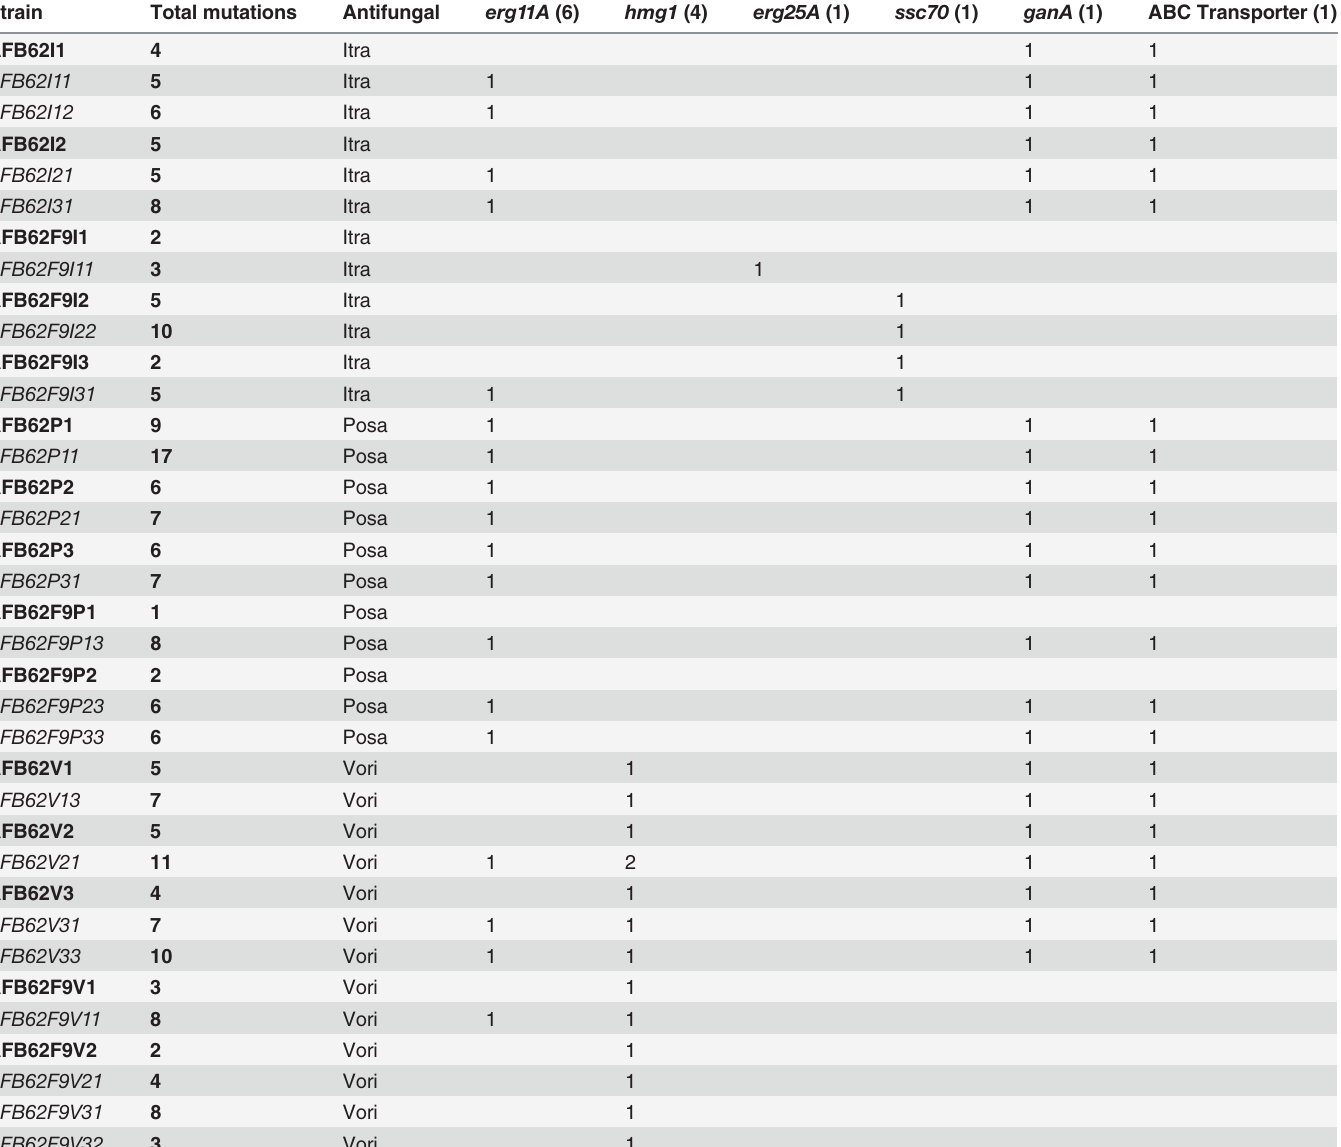
Table 1. Total number of SNP of sequenced AFB62 or AFB62F9 intermediate (bold) and high level resistant isolates in itraconazole, posaconazole, or voriconazole after in vitro